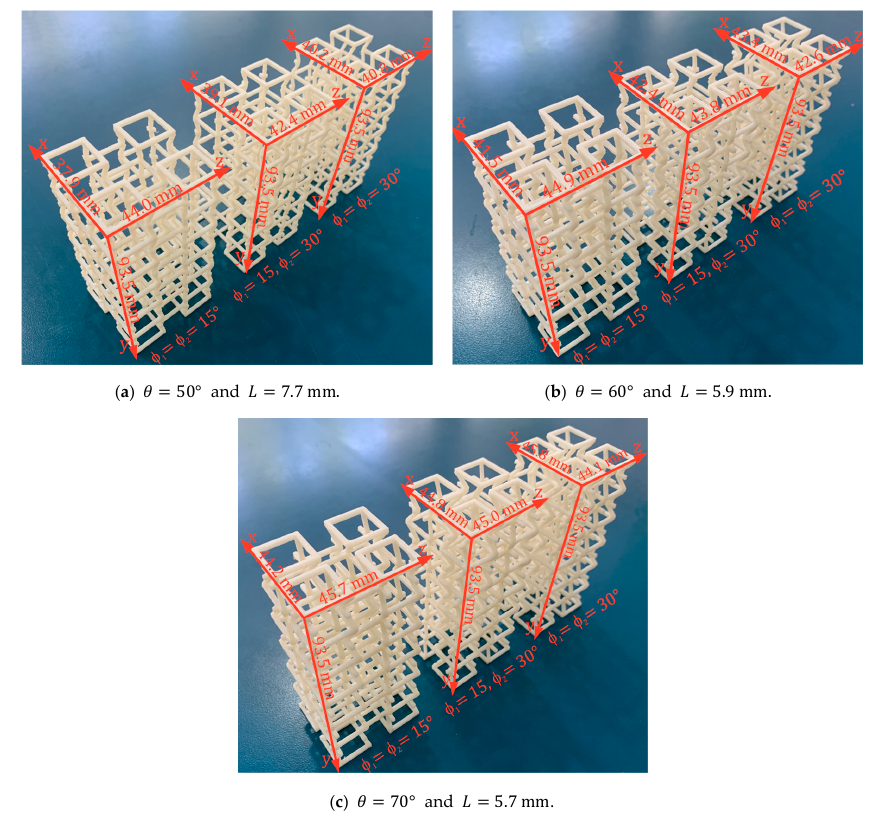
Figure 8. Beams made up of 24-unit cells ( 2 × 2 × 6 ) manufactured through fused filament fabrication. Considering H = 13.6 mm and t = 1.7 mm for all cases. Each sample was loaded in the x and z directions. However, the structures that have a rotation angle ∅ (cid:2869) (cid:3404) 15° and ∅ (cid:2870) (cid:3404) 30° were tested in the positive direction (cid:4666)(cid:3397)𝑧(cid:4667) , and they were also rotated by 180° to be tested in the negative direction (cid:4666)(cid:3398)𝑧(cid:4667) , as shown in Figure 9. Due to the asymmetry that this structure possesses, it is expected that it will experience a different mechanical behavior in these two load directions. During all exper ‐ iments, the testing machine automatically records the applied force and vertical displace ‐ ment produced.